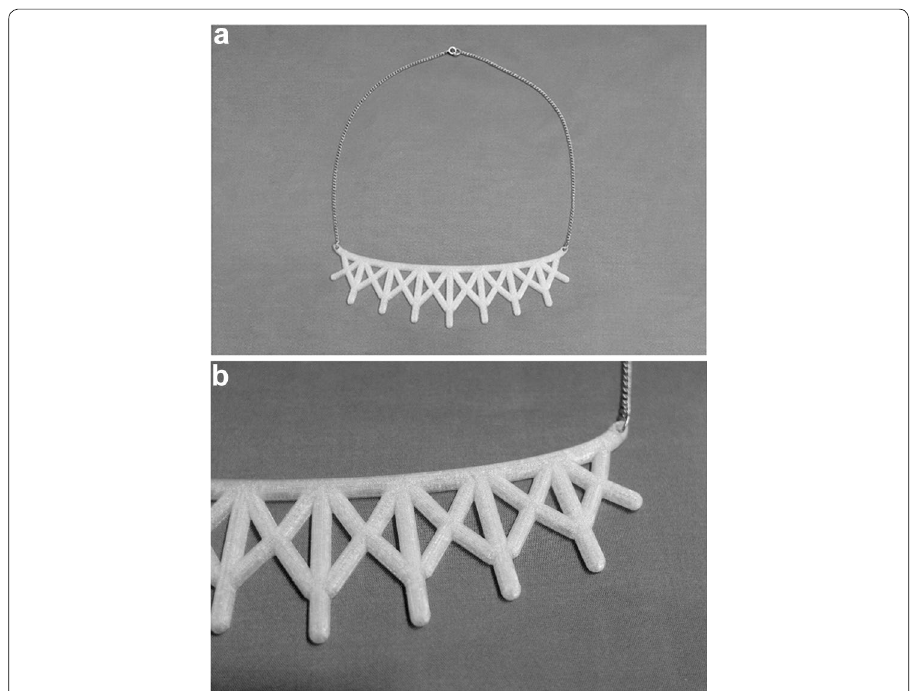
Fig. 5 a Jewelry pendant design 2 (clear PLA filament). b Zoomed view of jewelry pendant design 2